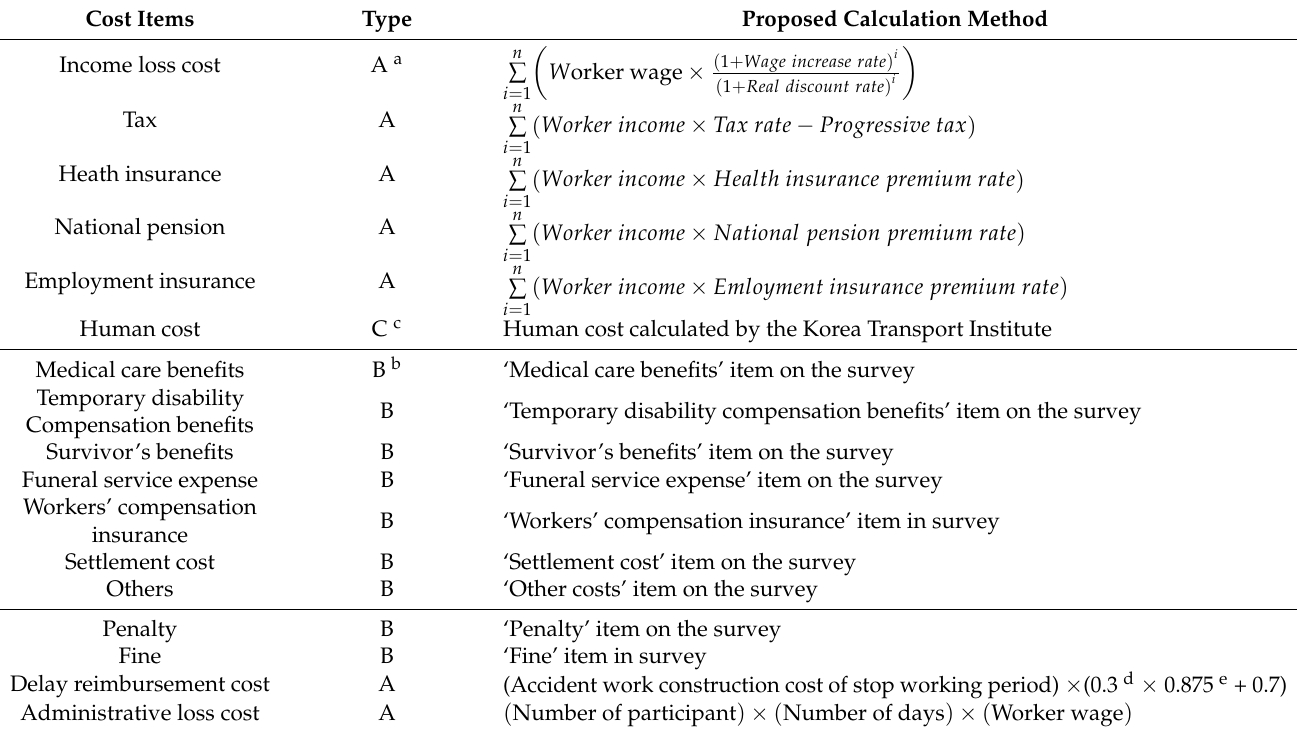
Table 3. Analysis methods of cost items on fatality